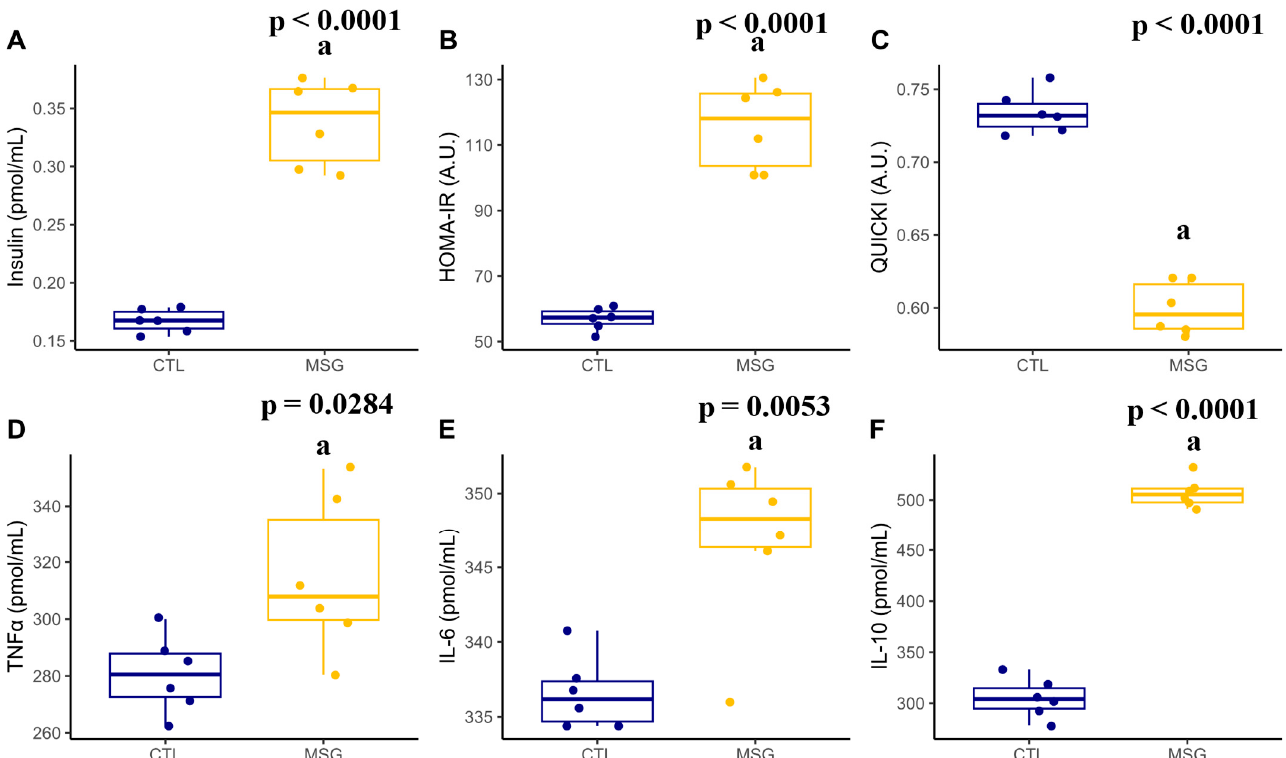
Figure 6. Graphs related to insulin and inflammatory plasmatic profile in PND15: ( A ): insulin (µIU/mL); ( B ): HOMA-R (A.U); ( C ): QUICKI (A.U); ( D ): TNF α (pmol/mL); ( E ): IL-6 (pmol/mL); ( F ): IL-10 (pmol/mL). The CTL is represented in blue and the MSG group is represented in yellow. The letter a represents the difference between the MSG group when compared to the CTL group. All data: Student’s t -test.